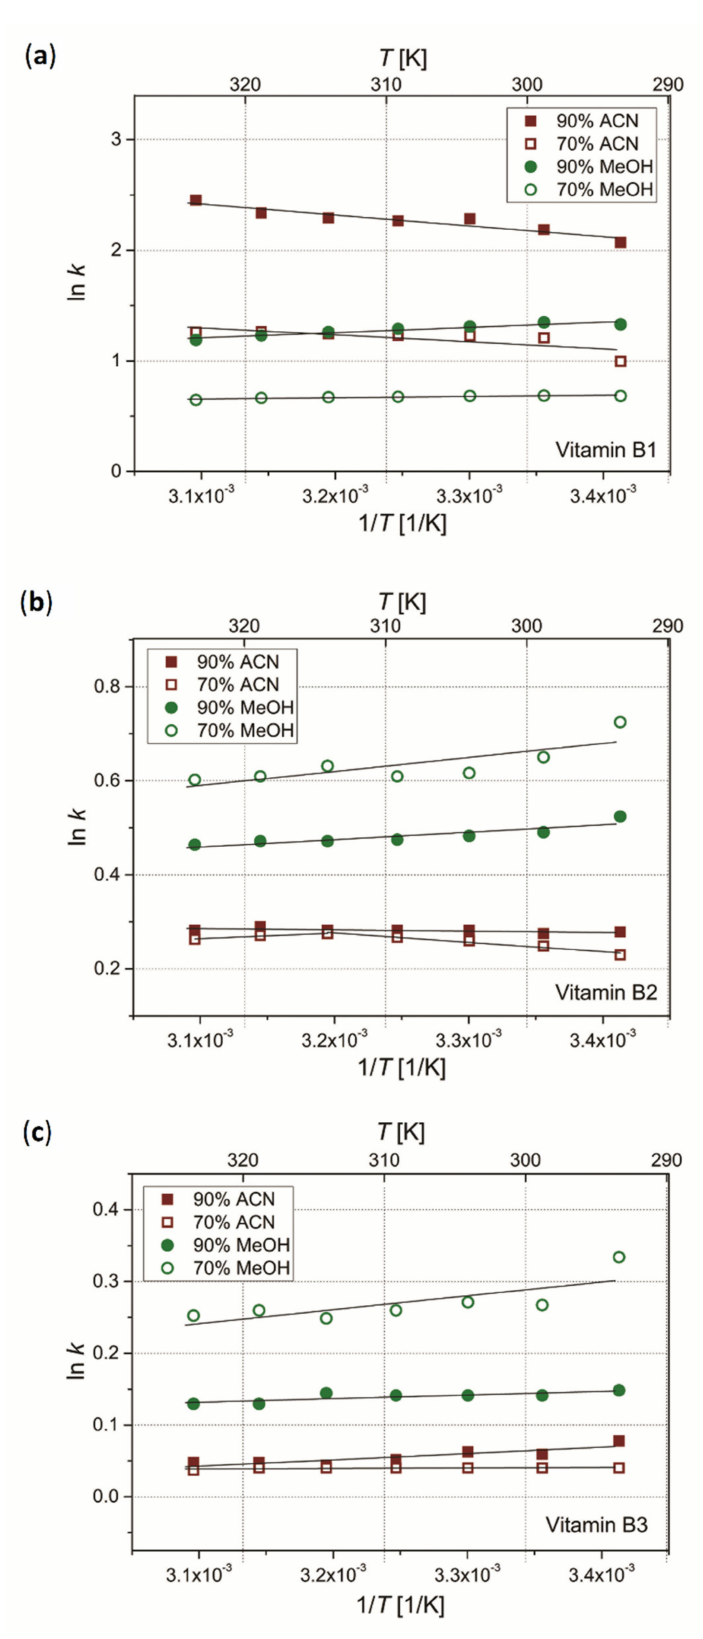
Figure 6. Effect of temperature on retention coefficient of: ( a ) vitamin B1, ( b ) vitamin B2 and ( c ) vitamin B3 in column N (Nucleodur C18